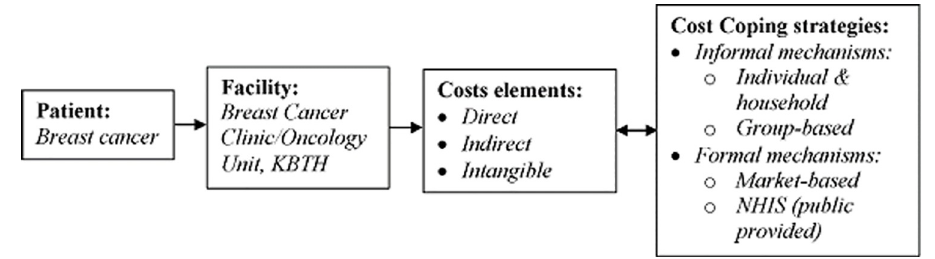
Fig 1. Analytical framework of household cost and coping strategy of breast cancer